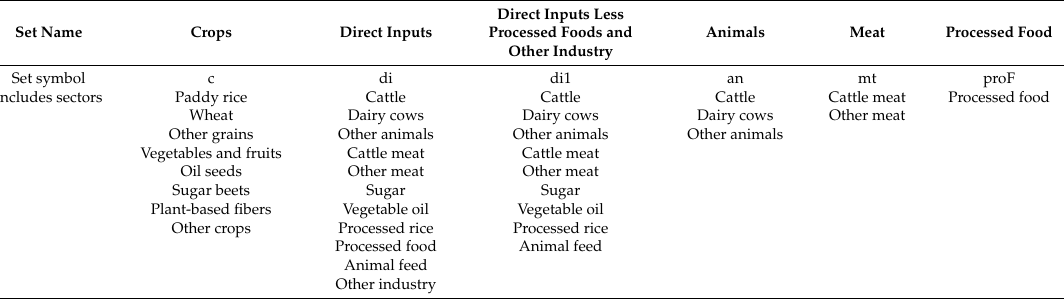
Table A1. Set definition for sector sets used in Formulas